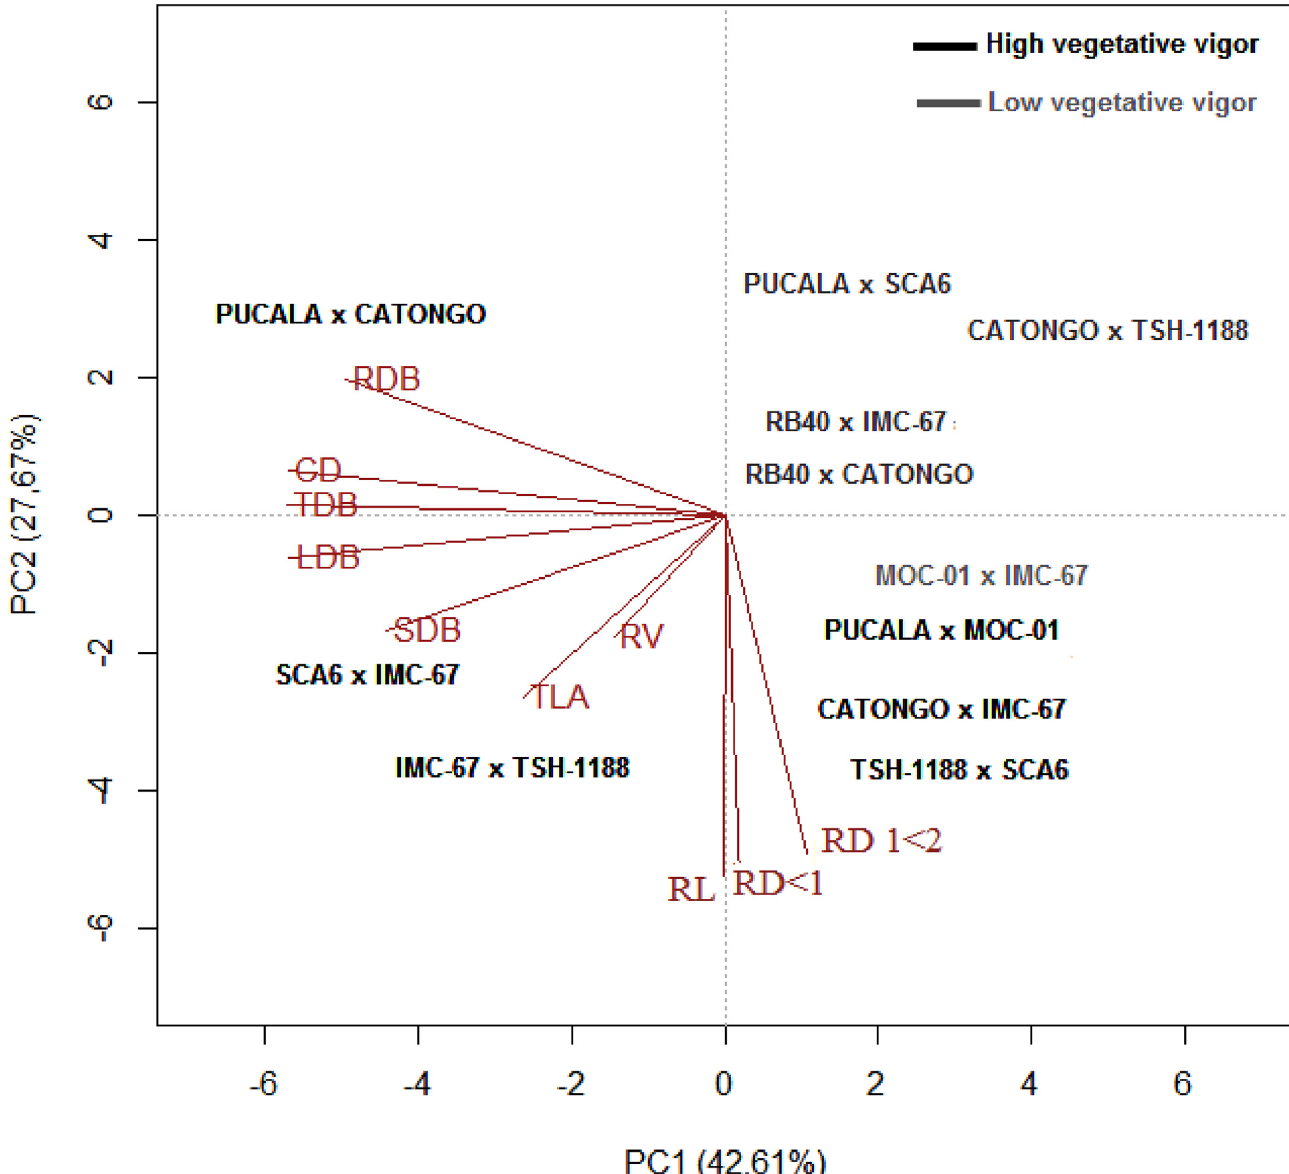
Fig 1. Biplot graphical analysis based on the mean of 21 cacao progenies under control condition ( Ψ WL between -0.1 and -0.5 MPa.) for CD, stem diameter; TLA, total leaf area; LDB, leaf dry biomass; SDB, stem dry biomass; TDB, total dry biomass; RDB, root dry weight; RL, root length; RV, root volume; RD, fine (RD < 1 mm) and medium (1 < RD < 2 mm) root